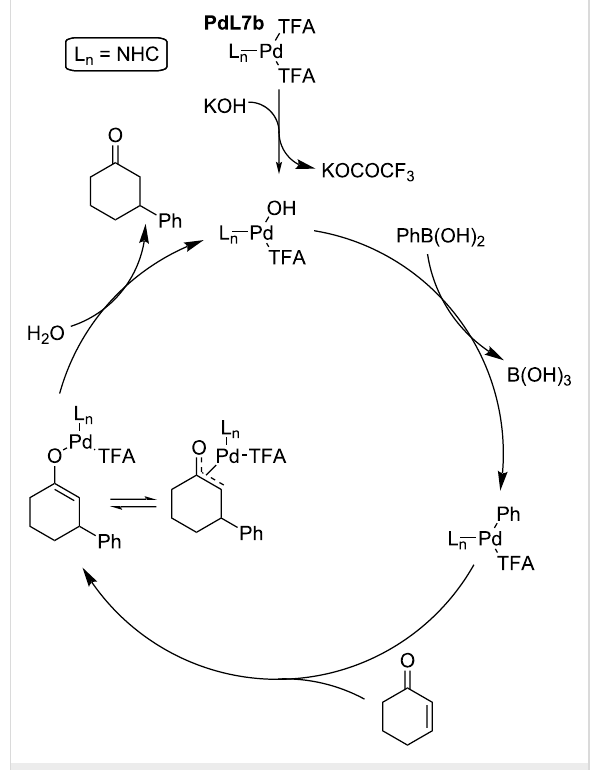
Table 16: Addition reactions of boronic acids to five and six-membered enones catalysed by in situ-prepared Pd-bisNHC complex PdL8 [46].